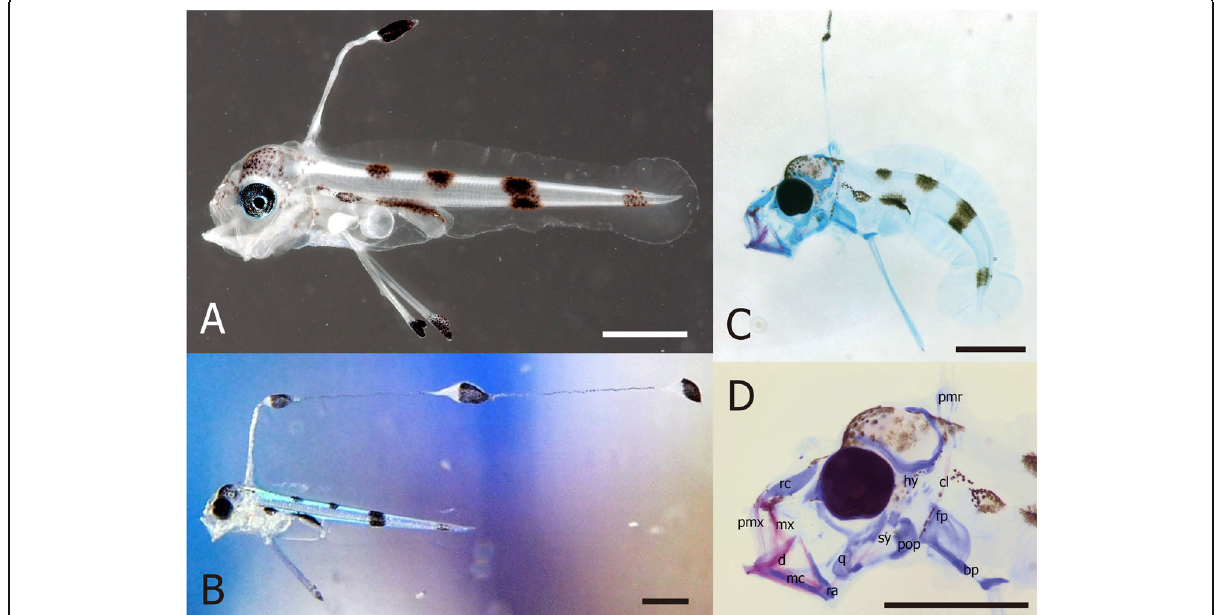
Fig. 3 Larvae of Regalecus russelii . a : larval specimen (5.5 mm notochord length (NL); 2 days after hatching (DAH); OCF-P04188, dorsal elongated filament was lost), b : living larvae ca. 6 mm NL (1 DAH), c : transparent specimen (5.5 mm NL; 4 DAH; OCF-P04196), d : close-up of transparent specimen head. Anatomical abbreviations: bp, basipterygium; cl, cleithrum; d, dentary; fp, fin plate cartilage; hy, hyomandibular; mc, Meckelian cartilage; mx, maxilla; pmr, proximal middle radial; pmx, premaxilla; pop, preopercle; q, quadrate; ra, retroarticular; rc, rostal cartilage; sy, symplectic. Scale bars: 1.0